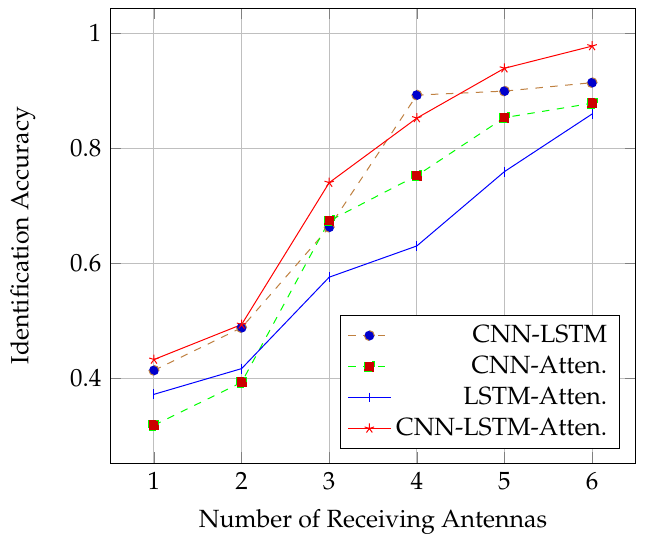
Figure 4. Identification rate in terms of the number of receiving antennas. Table 2. Network architectures of the CNN and LSTM with spatiotemporal attention.